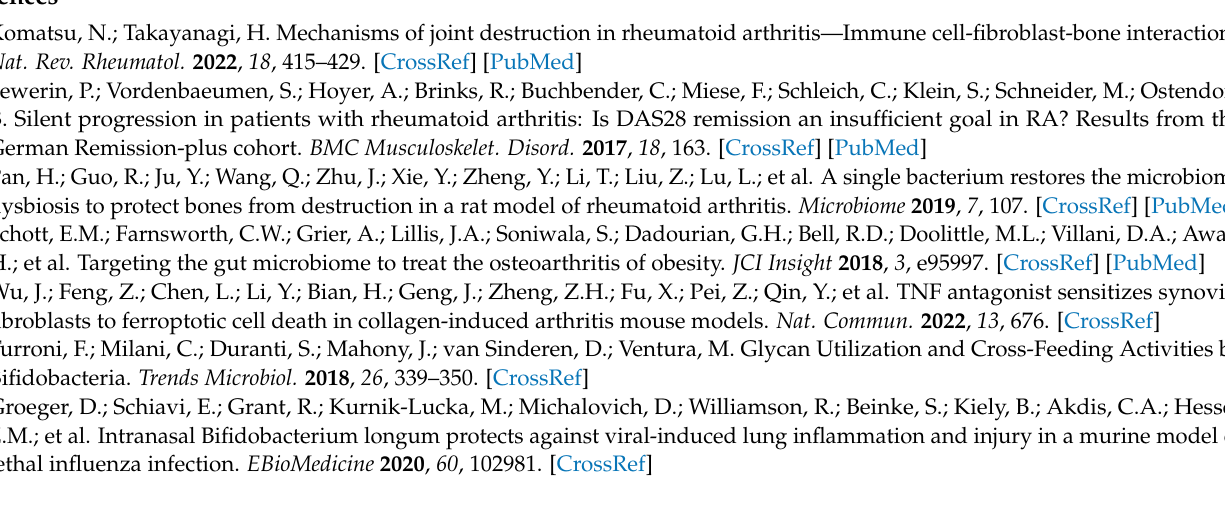
Table S2: Information on Cohort II: Validation test—Another clinical retrospective